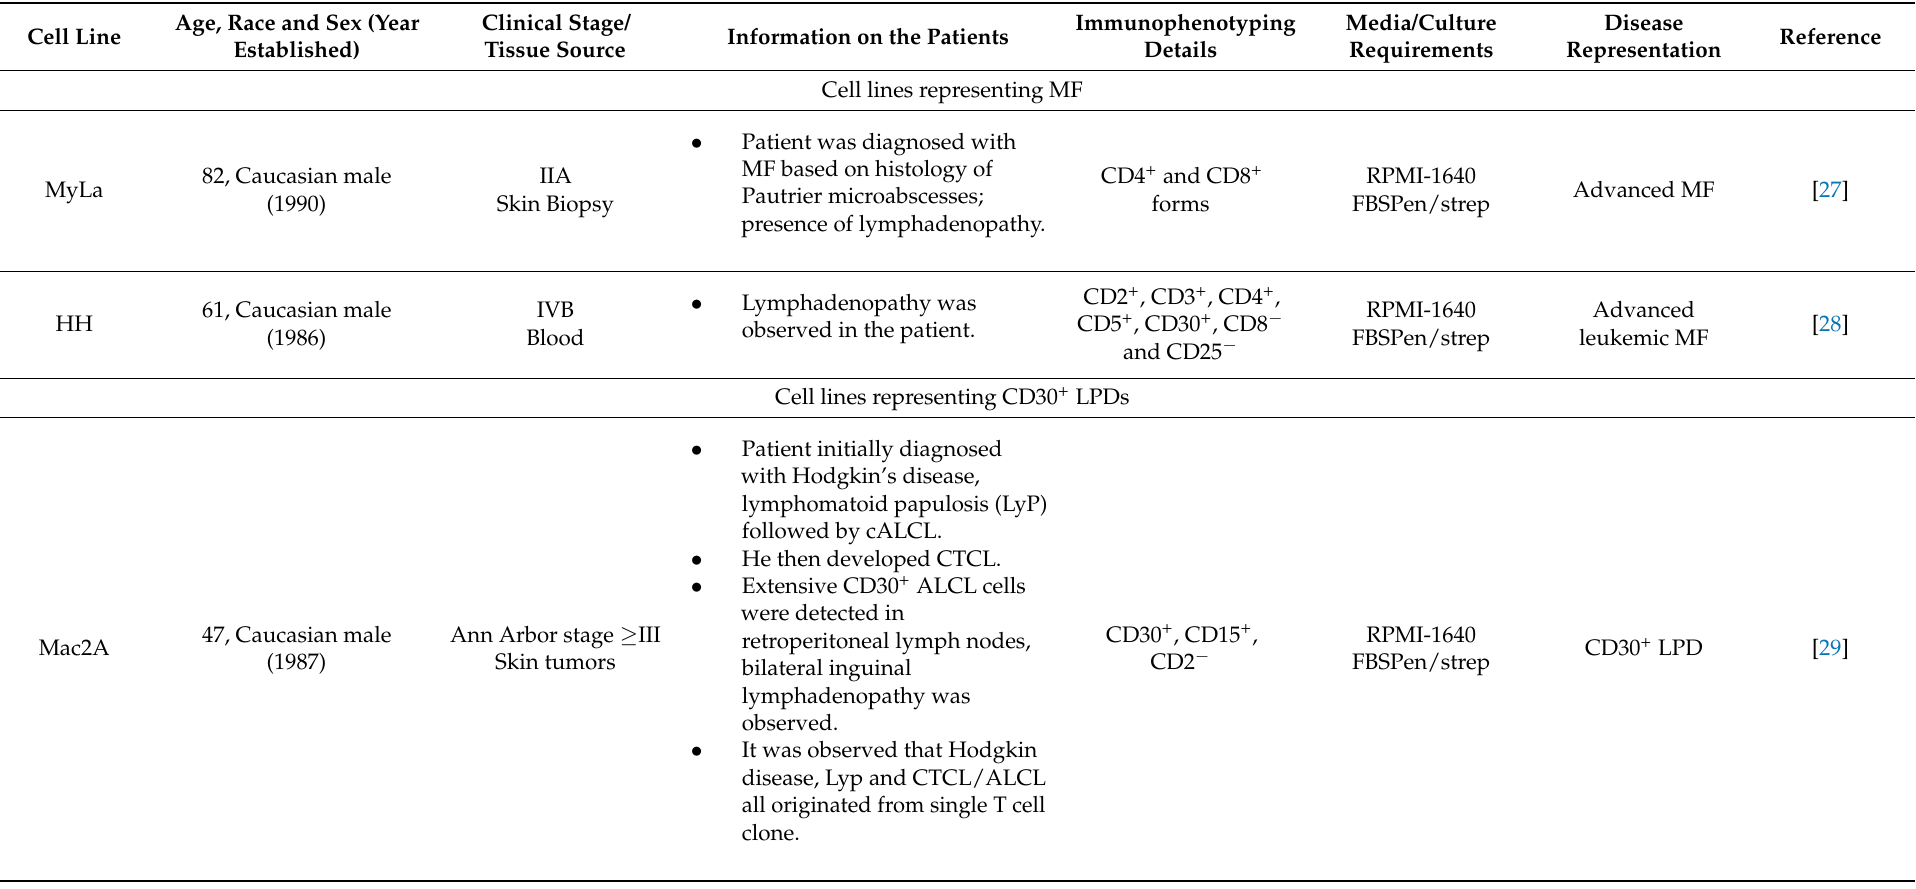
Table 1. Summary of the cell lines used to study